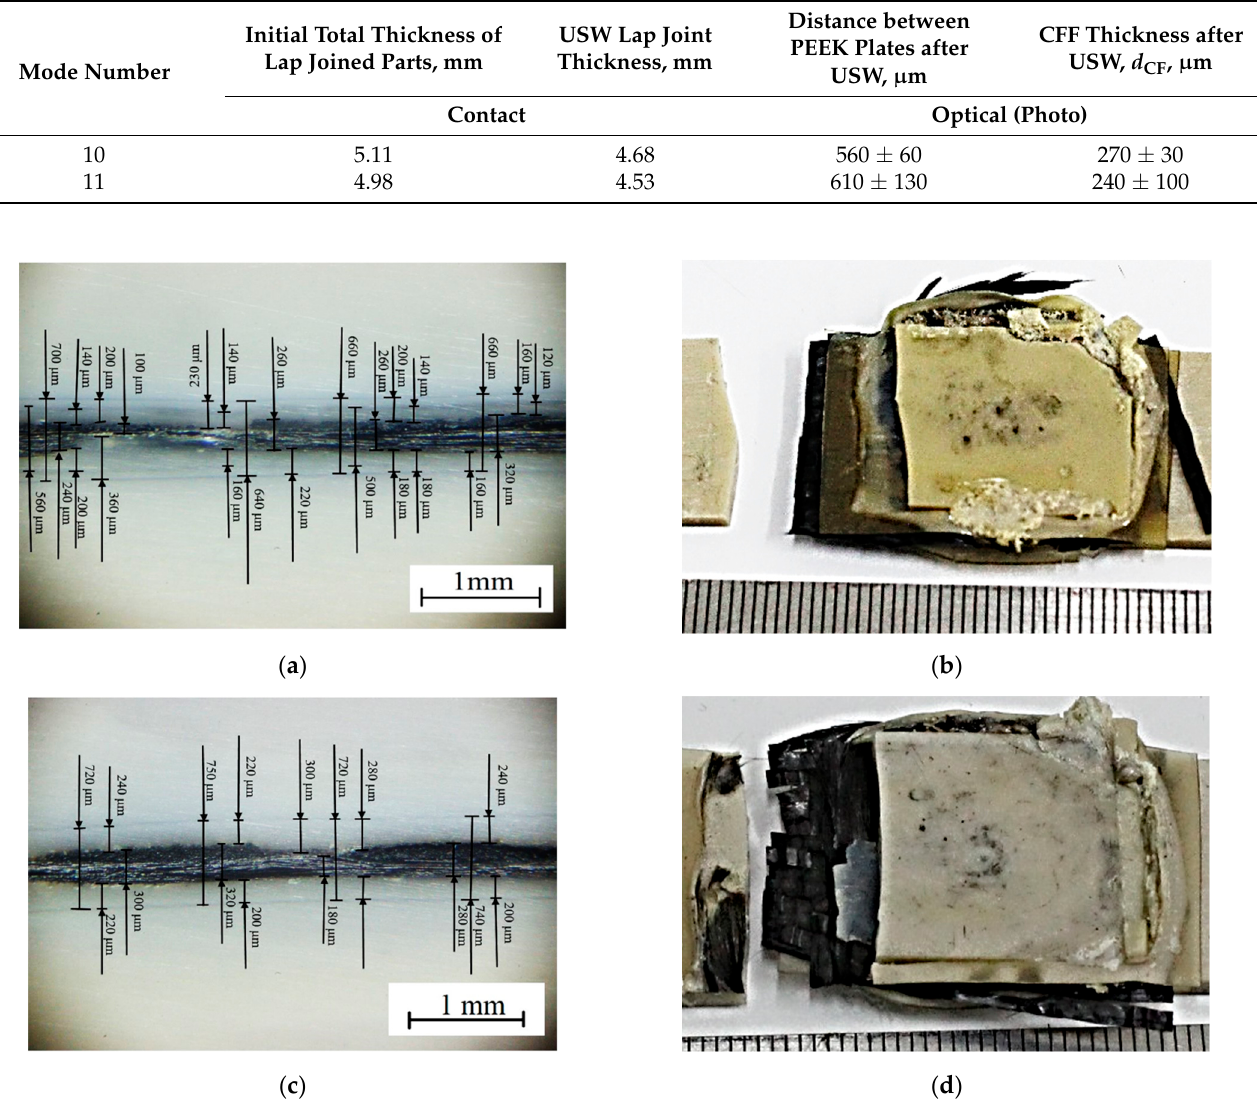
Figure 9. Optical images of the cross sections ( a , c ) and general views of the failed USW lap joints after the tensile tests ( b , d ) obtained by using modes 10 ( a , b ) and 11 ( c , d